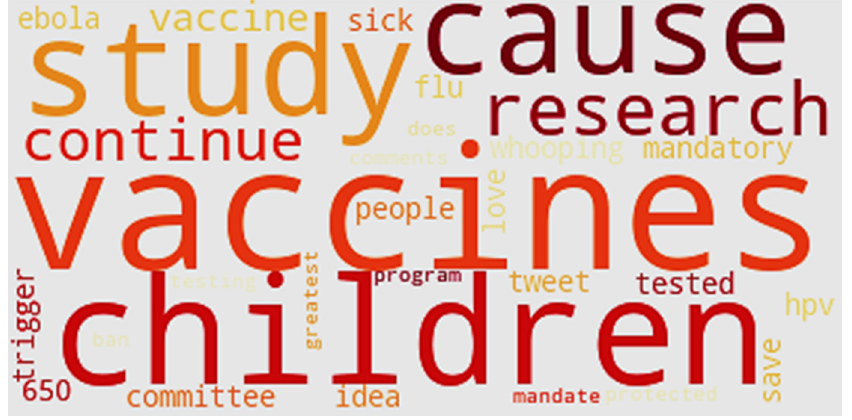
Figure 16. Word cloud of Cluster 1.